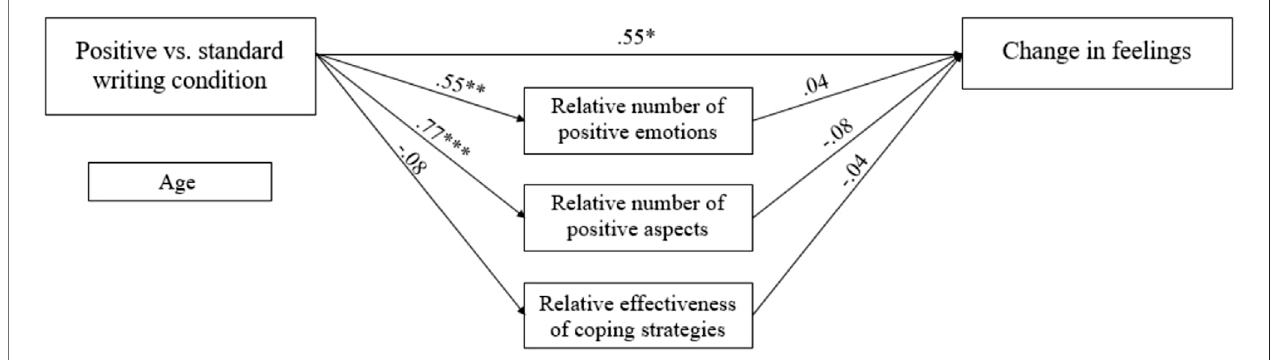
FIGURE 1 | Mediation model: positive vs. standard writing